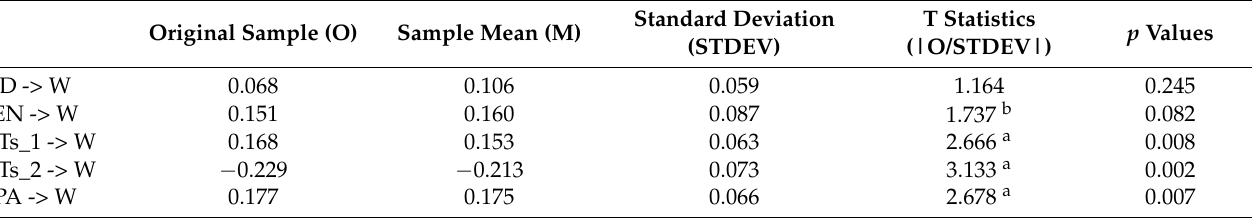
Table 2. Hypothesis tests between constructs and excess